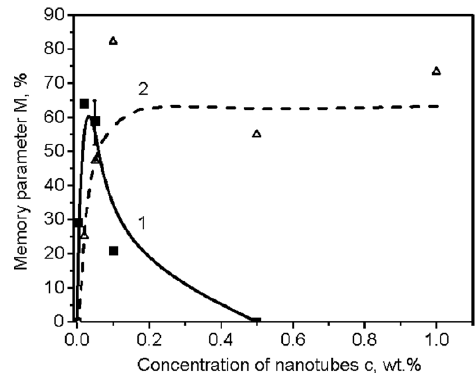
Figure 12. The memory efficiency M as a function of the weight concentration of carbon nanotubes for the different liquid crystals mixtures: (1) p-ethoxy-benzylidene-p-n-butylaniline- (EBBA) based series and (2) MLC6608-based series [64].